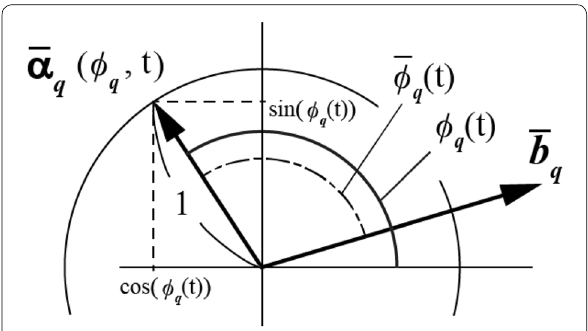
Fig. 4 Relation between vector ¯ b q of controlled plant and